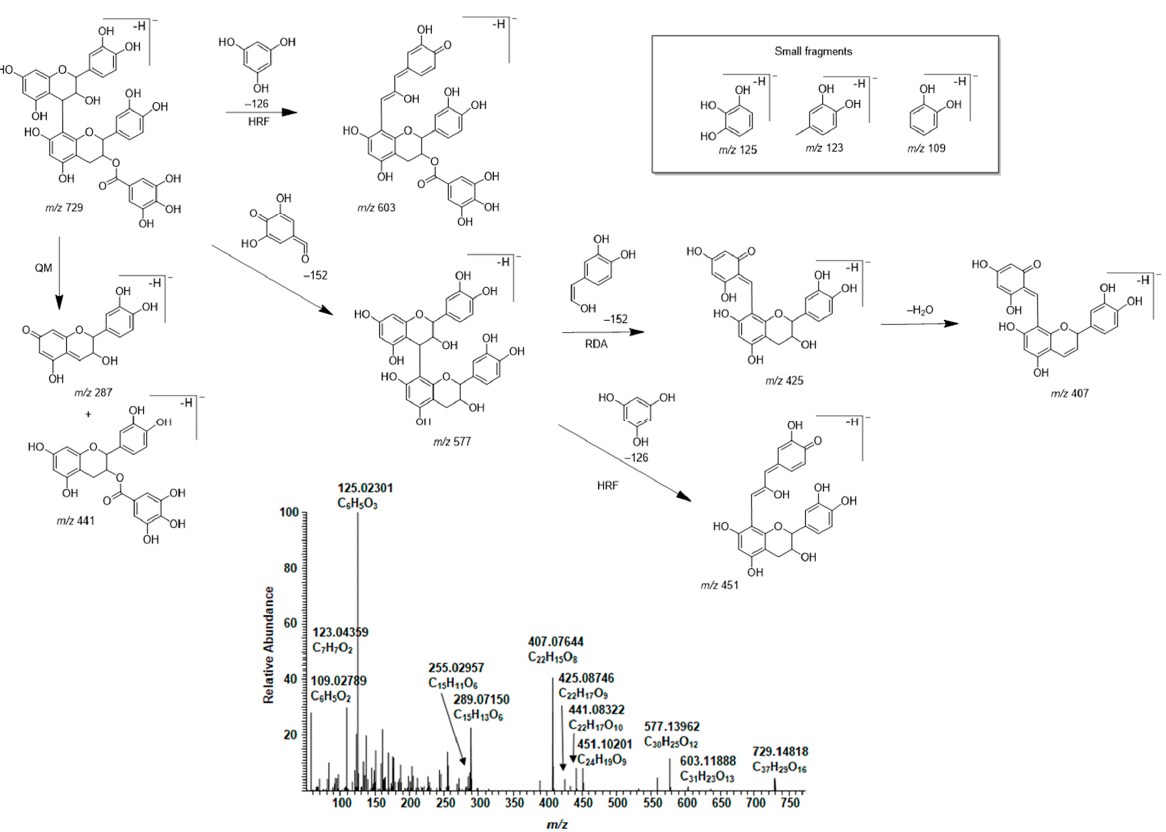
Figure 11. Characteristic fragmentation pathway and the MS/MS of a galloylated procyanidin dimer in the leaf extract of Ruprechtia salicifolia . The position of the galloyl group is only indicative and could be any free OH group in the terminal unit. The mechanisms are heterocyclic ring fission (HRF), retro-Diels ‒ Alder (RDA) fragmentation and quinone methide (QM) cleavage.